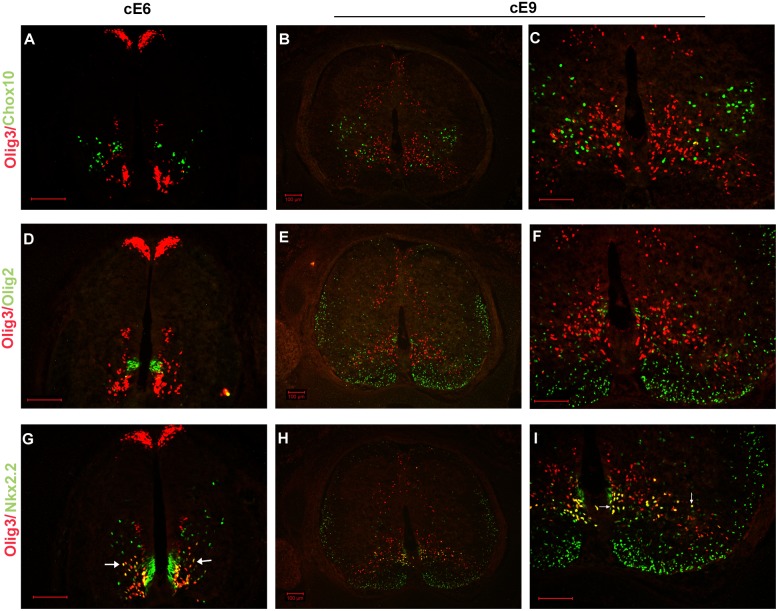
Olig3 is expressed in the cells derived from p2 and p3 domains.cE6 and cE9 chicken spinal cord sections were double-immunostained with anti-Olig3 (red), anti-Chx10 (green), anti-Olig2 (green) and anti-Nkx2.2 (green). Olig3 was expressed in the cells derived from p2 and p3 domains of ventricular zone, but not in Olig2+ motor neuron progenitor cells and oligodendrocytes. C, F, I are the high power views of B, E, H, respectively, in the ventrolateral region. Double positive cells are indicated with arrows. The dorsal part is up. Bars, 100 µm.